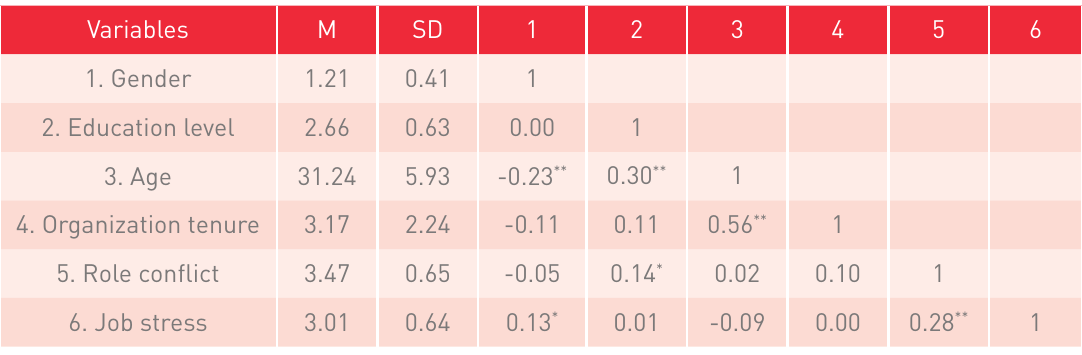
Descriptive statistics of the study